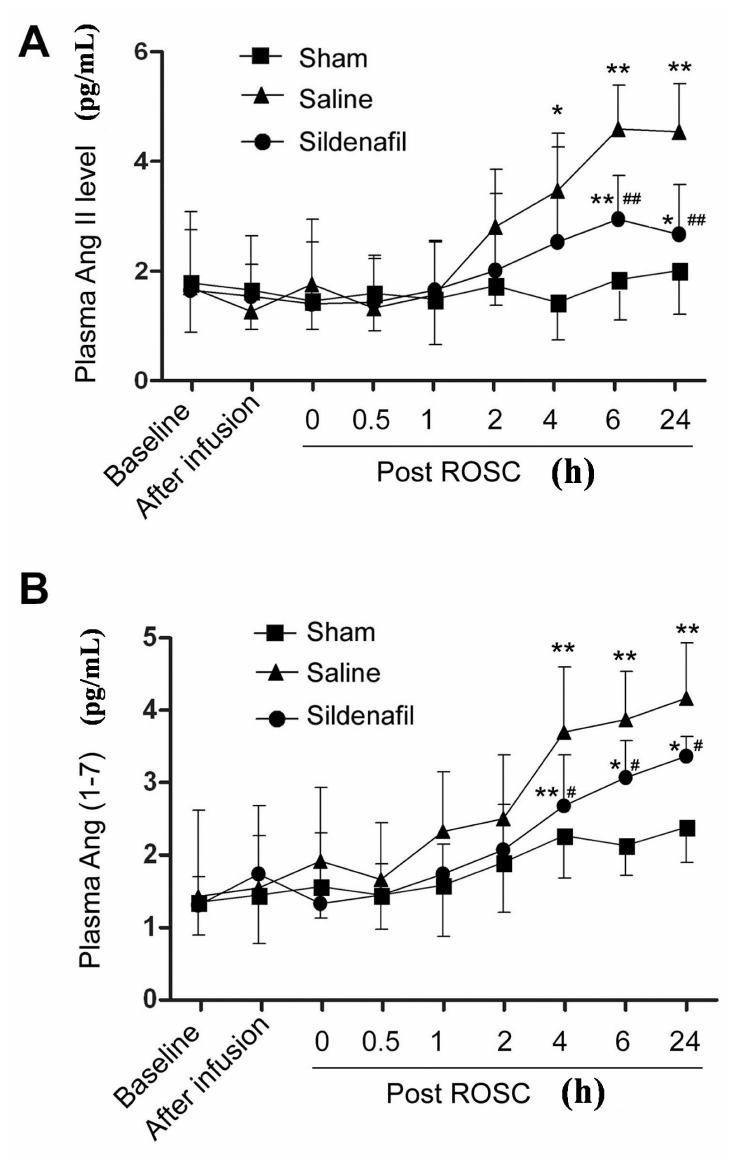
Figure 3. Plasma levels of the RAS components Ang II and Ang (1–7) in a porcine myocardial I/R injury model. ELISA determination of Ang II ( A ) and Ang (1–7) ( B ) at 0, 0.5, 1, 2, 4, 6 and 24 h in sham, saline, and sildenafil-treated groups following restoration of spontaneous circulation (post ROSC, h) were determined by ELISA. * p < 0.05 vs. Sham, ** p < 0.01 vs. Sham, # p < 0.05 vs. Saline, ## p < 0.01 vs Saline n = 6–10 per